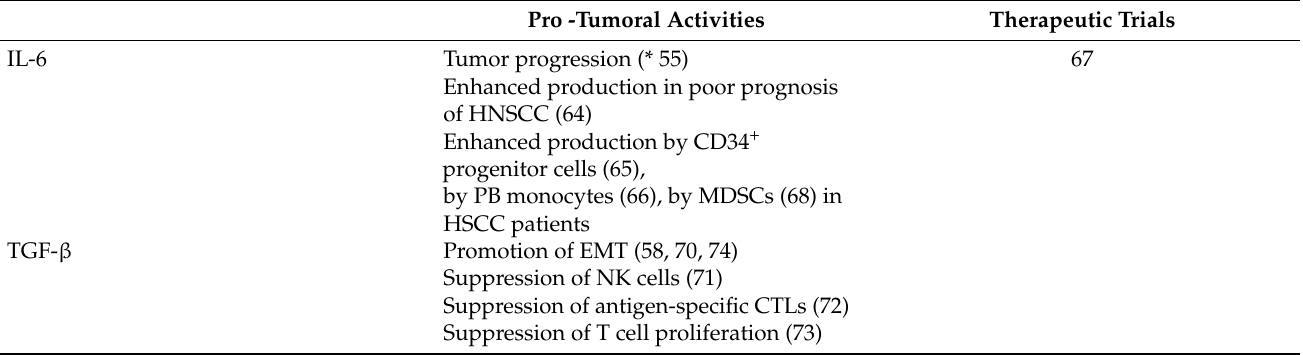
Table 2. Representative pro- and anti-inflammatory cytokines relevant to pro-tumoral and therapeutic trials for HNSCCs.